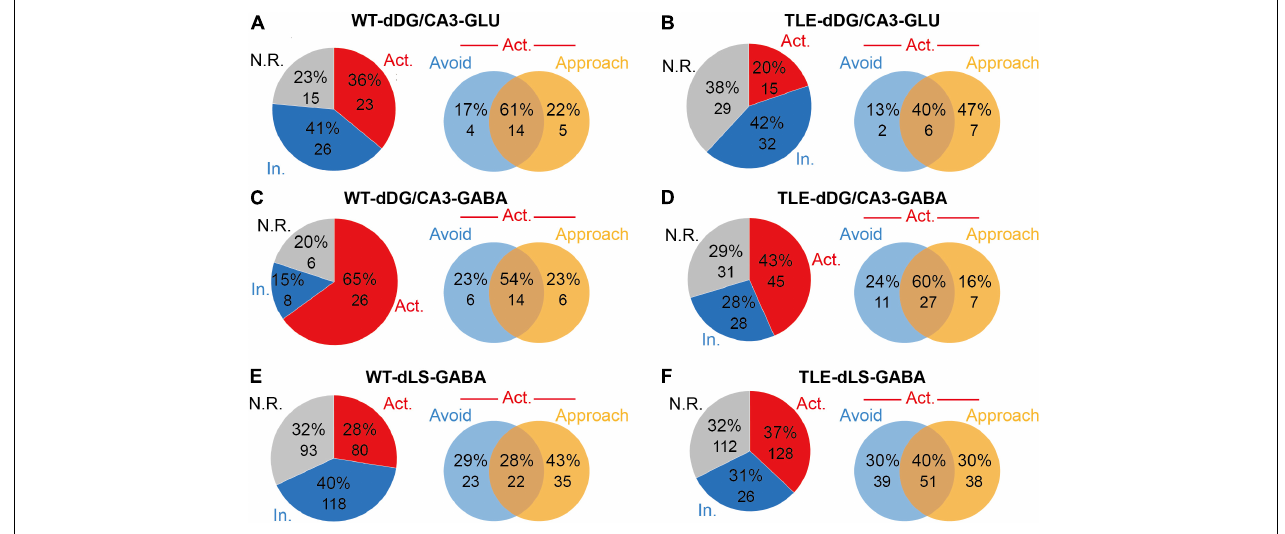
FIGURE 3 | Electrophysiological analysis showed E/I imbalance in TLE mice. (A) Neuronal response types of putative glutamatergic neurons to RA in dDG/CA3 of WT mice [Red, excited (Act.); blue, inhibited (In.); gray, no response (N.R.). n = 64 cells from 5 mice]. Venn diagram shows the distribution of approached RA-excited only, avoid RA-excited only or dual-excited putative glutamatergic neurons in dDG/CA3 of WT mice at RA. (B) Neuronal response types of putative glutamatergic neurons to RA in dDG/CA3 of TLE mice (Red, excited; blue, inhibited; gray, no response; n = 76 cells from 5 mice). Venn diagram shows the distribution of approached RA-excited only, avoid RA-excited only or dual-excited putative glutamatergic neurons in dDG/CA3 of TLE mice at RA. (C) Neuronal response types of putative GABAergic neurons to RA in dDG/CA3 of WT mice (Red, excited; blue, inhibited; gray, no response; n = 40 cells from 17 mice). Venn diagram shows the distribution of approached RA-excited only, avoid RA-excited only or dual-excited putative glutamatergic neurons in dDG/CA3 of WT mice at RA. (D) Neuronal response types of putative GABAergic neurons to RA in dDG/CA3 of TLE mice (Red, excited; blue, inhibited; gray, no response; n = 104 cells from 15 mice). Venn diagram shows the distribution of approached RA-excited only, avoid RA-excited only or dual-excited putative glutamatergic neurons in dDG/CA3 of TLE mice at RA. (E) Neuronal response types of putative GABAergic neurons to RA in dDG/CA3 of WT mice (Red, excited; blue, inhibited; gray, no response; n = 291 cells from mice). Venn diagram shows the distribution of approached RA-excited only, avoid RA-excited only or dual-excited putative glutamatergic neurons in dLS of WT mice at RA. (F) Neuronal response types of putative GABAergic neurons to RA in dDG/CA3 of TLE mice (Red, excited; blue, inhibited; gray, no response; n = 346 cells from mice). Venn diagram shows the distribution of approached RA-excited only, avoid RA-excited only or dual-excited putative glutamatergic neurons in dLS of TLE mice at